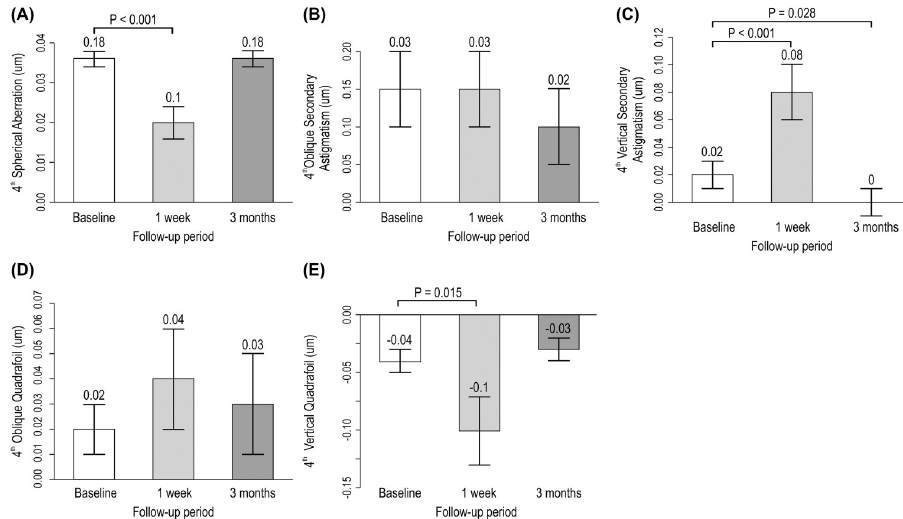
Fig 3. Change in fourth-order aberration ( μ m) according to follow-up time. Data expressed as mean ± standard error.